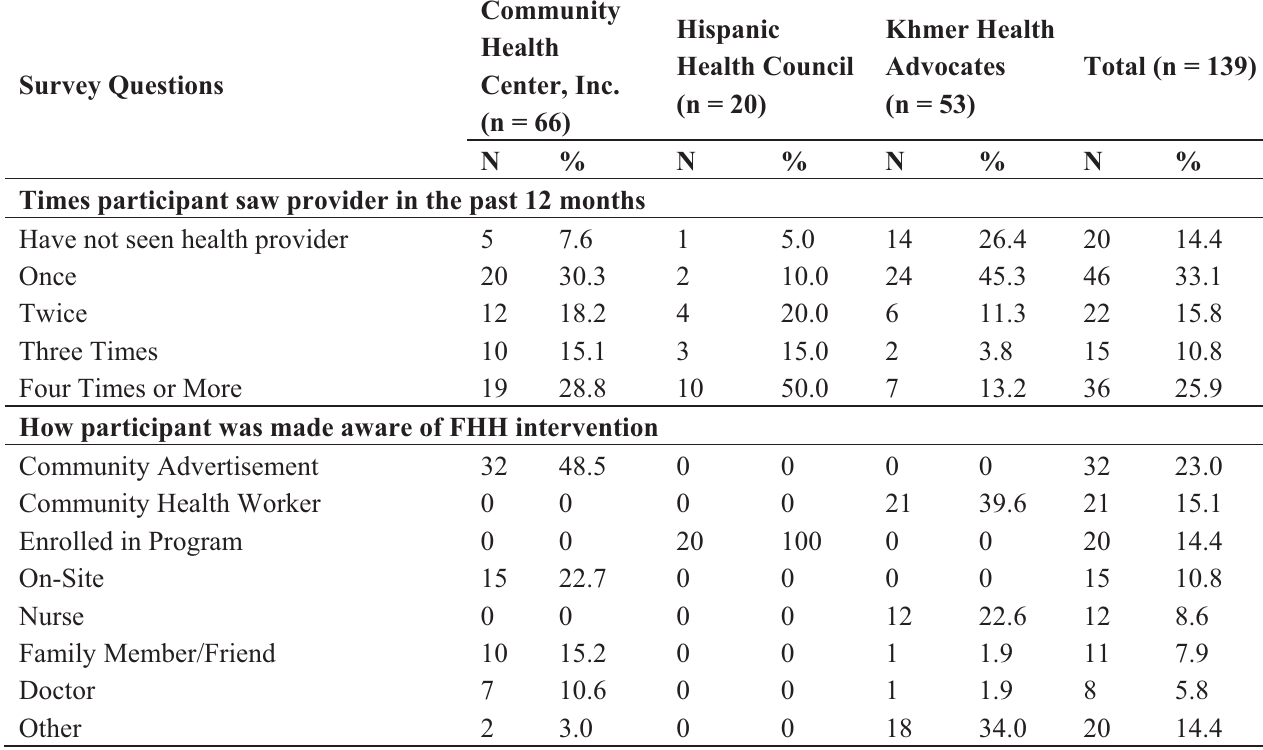
Table 4. Descriptive statistics of FHH participants previous visit to a medical provider and knowledge of FHH event (n =